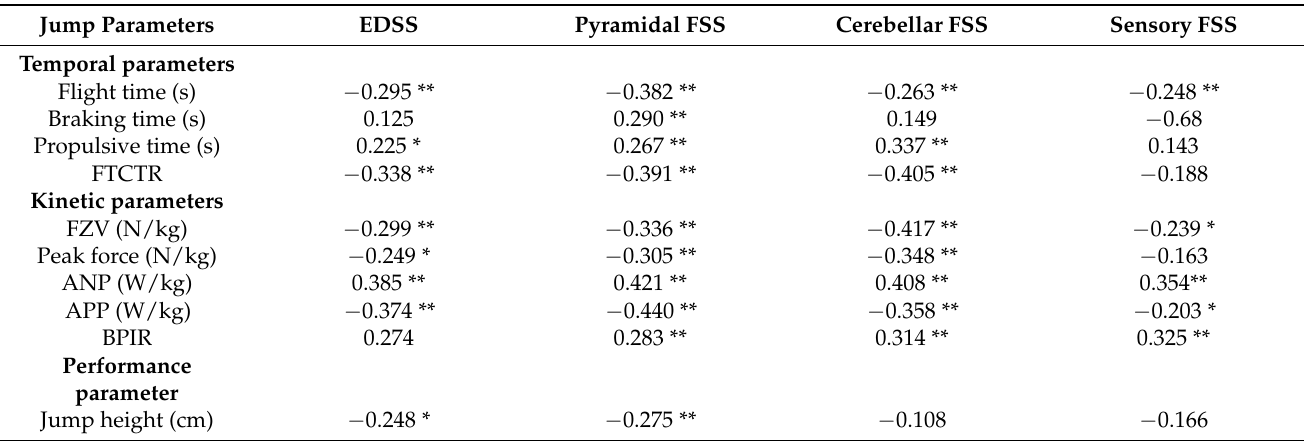
Figure 4. Group comparison between pwMS unimpaired and HC according to normal sensory and cerebellar FSS for temporal, kinetic and performance jump parameters. Data presented as mean with standard deviation and significance indicators (*** p ≤ 0.001; ** p < 0.01; * p < 0.05). Abbreviations: HC = healthy controls; pwMS = people with multiple sclerosis; FTCTR = flight time to contraction time ratio; Avg. = average; BPIR= brake to propulsive impulse ratio. Table 4. Correlation between jump parameters and EDSS including pyramidal, cerebellar and sensory FSS in pwMS ( n = 99) according to